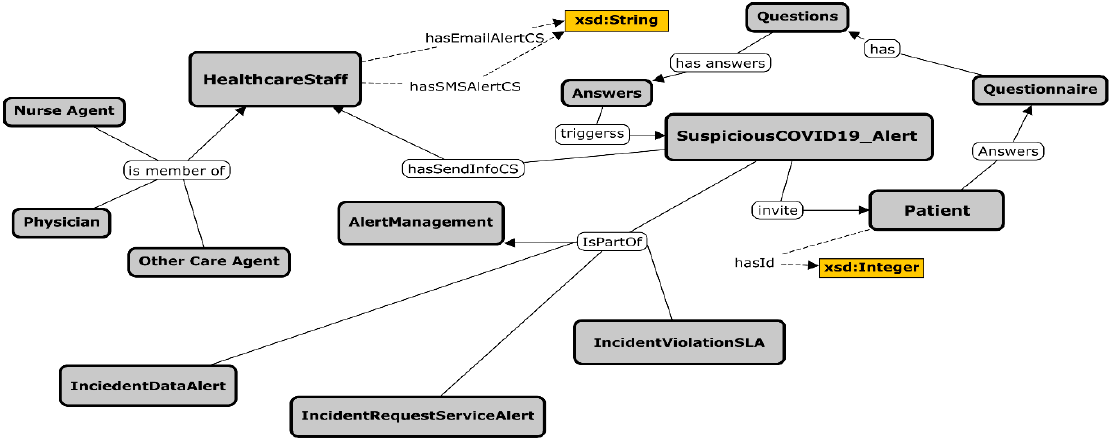
Figure 11. Alert ontology.